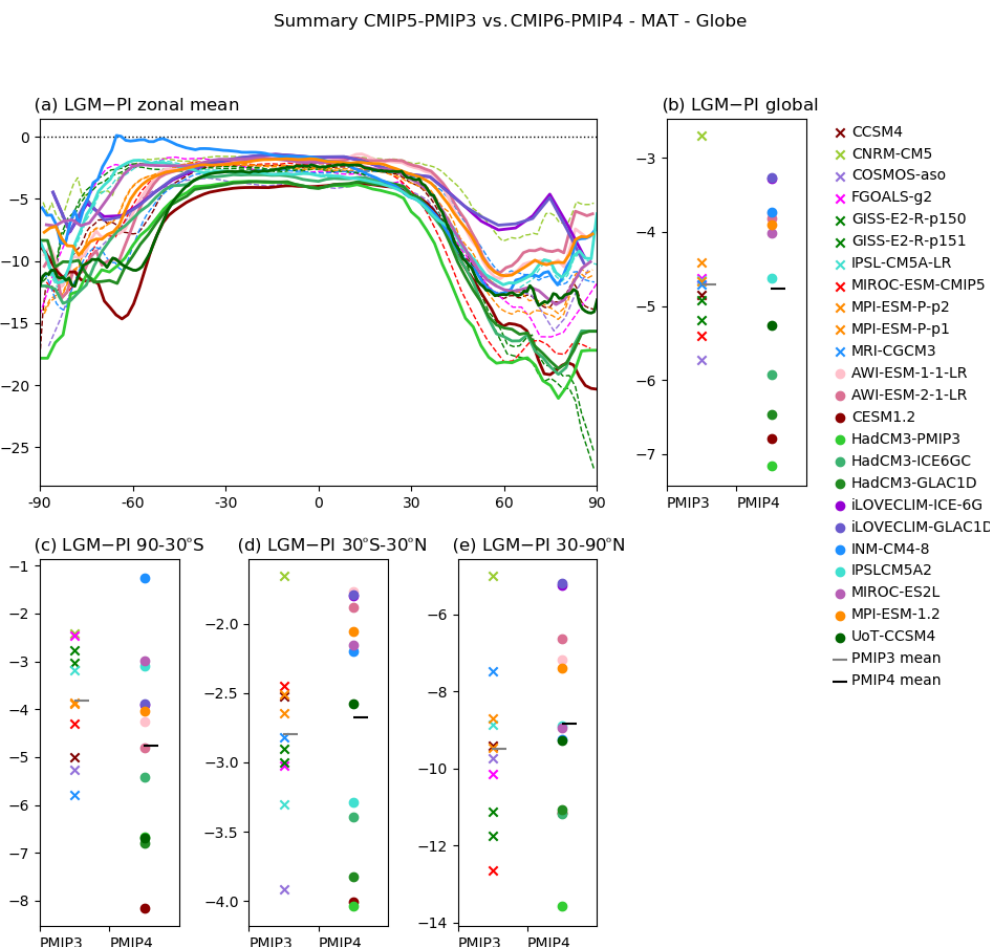
Figure 1. Mean annual surface air temperatures LGM–PI anomalies in ◦ C. (a) Zonal means, PMIP3 model results shown as dashed lines, PMIP4 model results shown as thick solid lines; (b) global means, PMIP3 model results shown by crosses, PMIP4 models shown by filled circles; averages over (c) the southern extratropics (90 to 30 ◦ S), (d) the tropics (30 ◦ S to 30 ◦ N) and (e) the northern extratropics (30 to 90 ◦